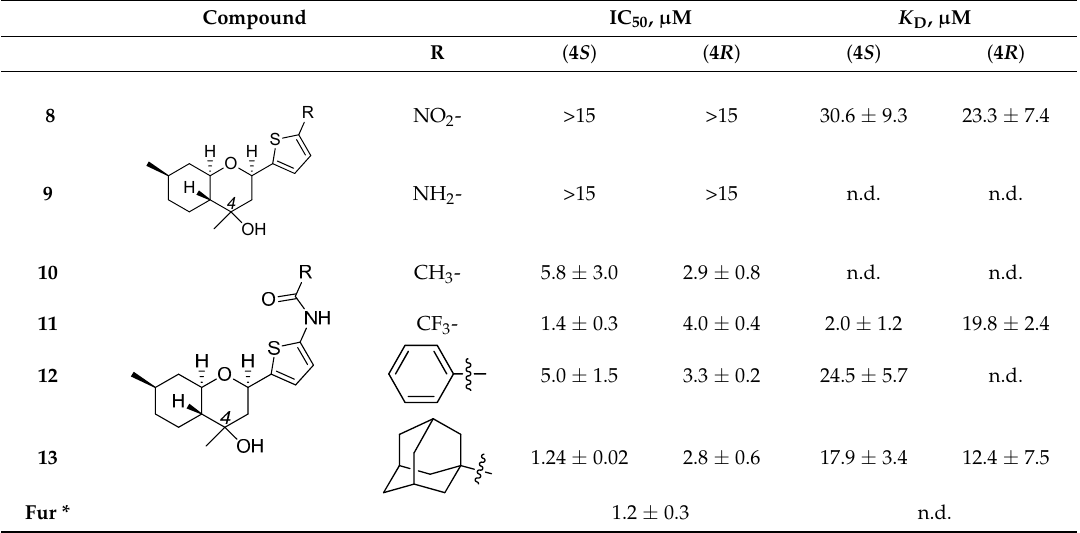
Table 1. Inhibitory Potency (IC 50 ) and Binding Affinity ( K D ) of Compounds 8–13 Against Tdp1.